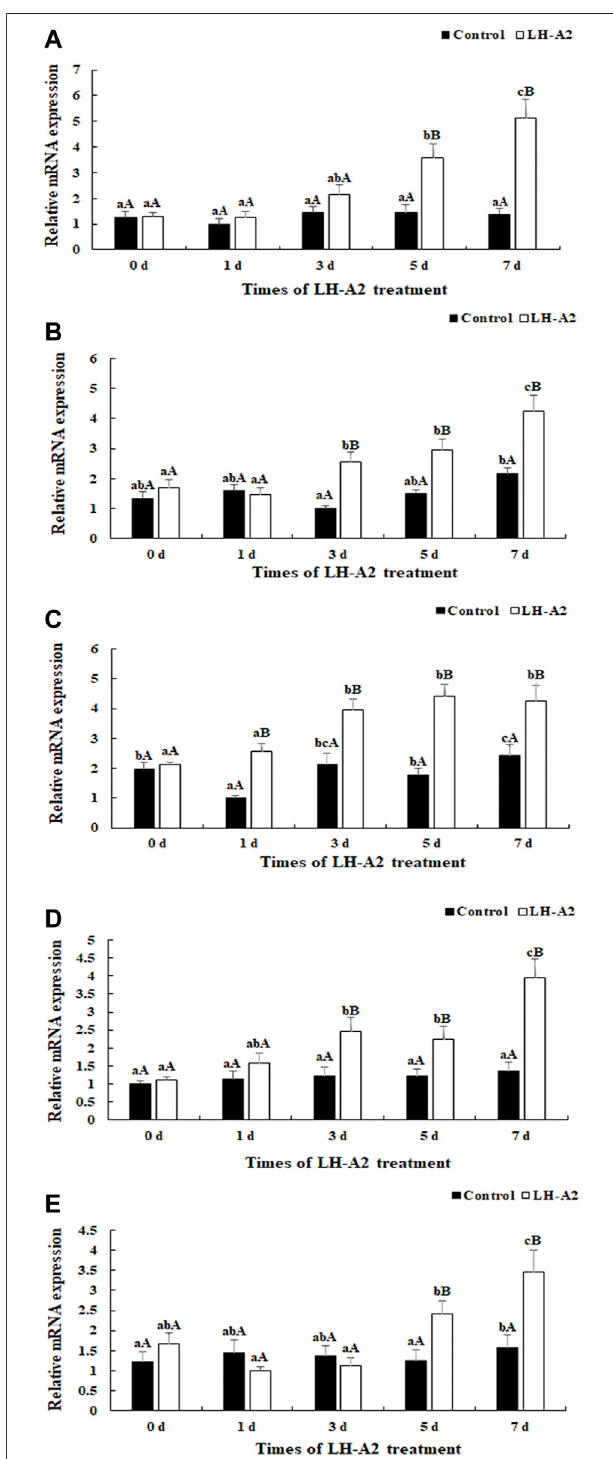
FIGURE 5 | Expression characterization of fi ve DEGs in gonad at different time points after the LH-A2 treatment. The amount of fi ve DEGs mRNA was normalized to the β -actin transcript level. Data are shown as mean ± SD (standard deviation ) of tissues from three biological replicates. Lowercases indicated the signifcant difference between different